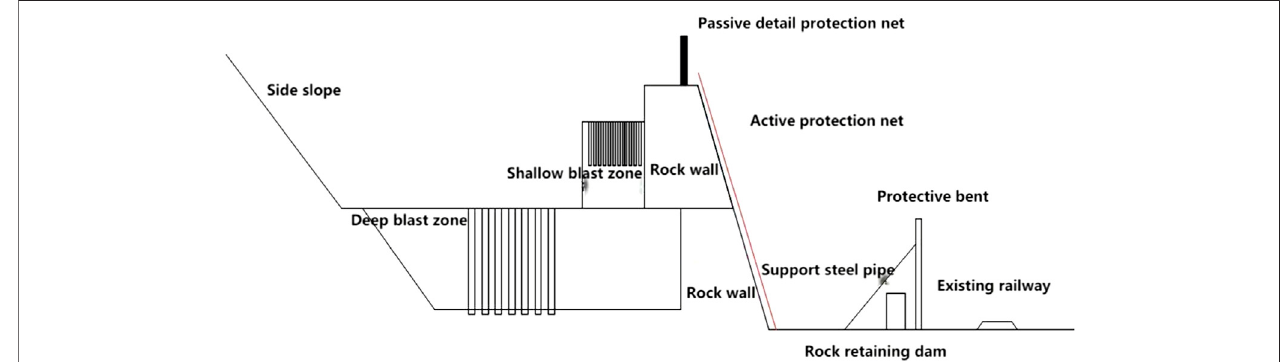
FIGURE 5 | Schematic diagram of main blasting scheme for reserved rock wall.